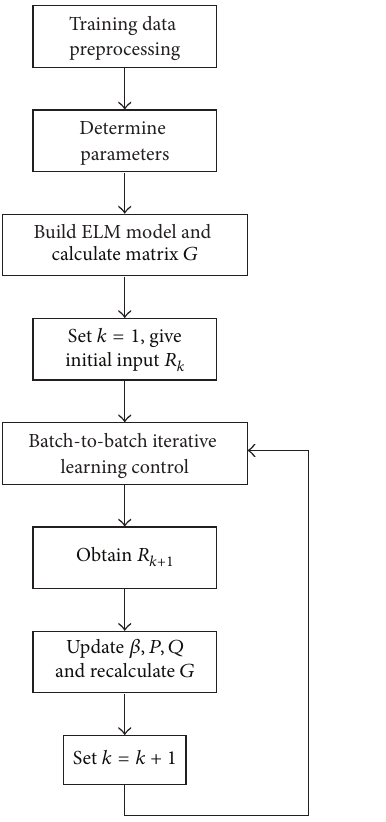
Figure 8: Iterative learning control effect of longitudinal wall